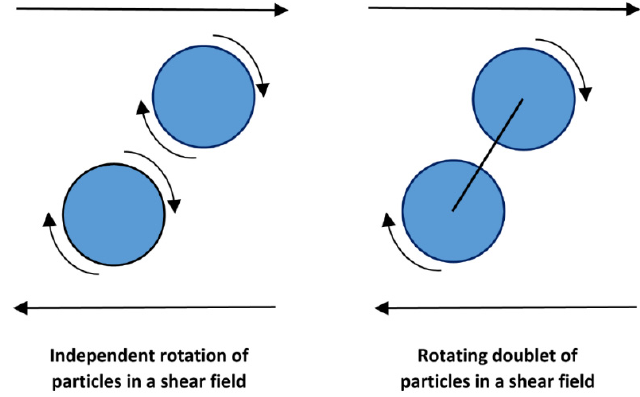
Figure 2. Formation of doublets of particles in shear flow of non-Brownian suspension.